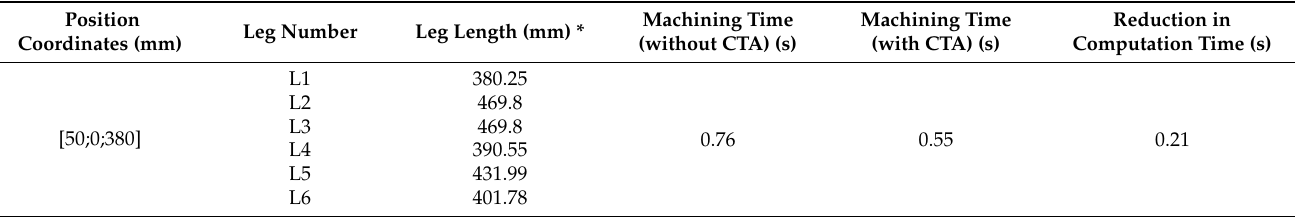
Table 7. Comparison of machining time obtained with and without